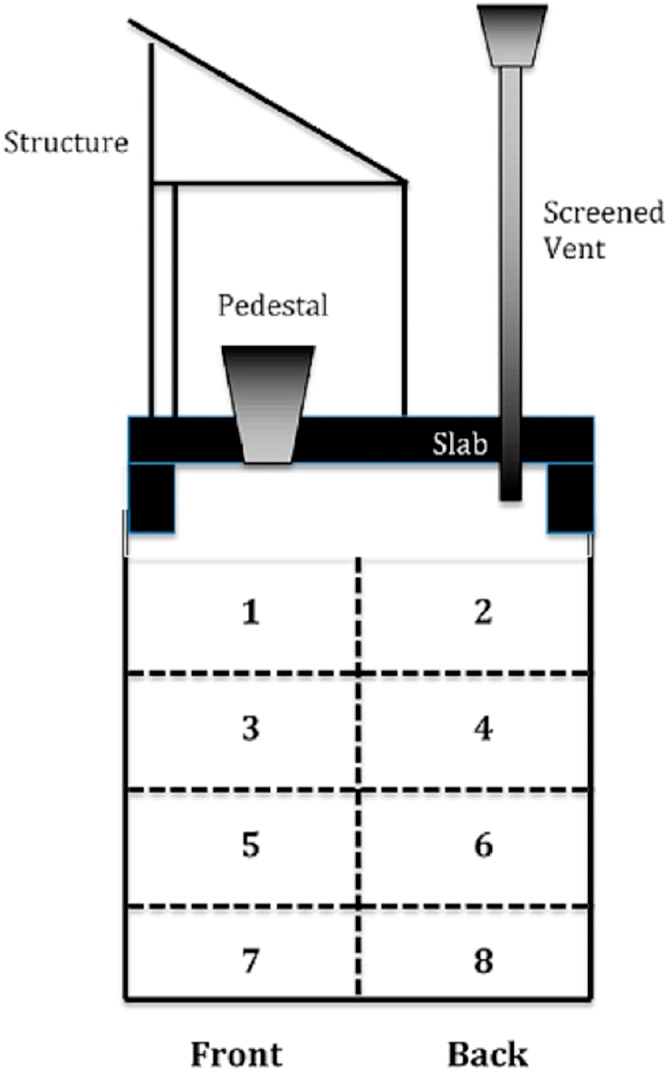
Scheme of the different sampling sections in the VIP latrine, after Zuma et al. (2015).